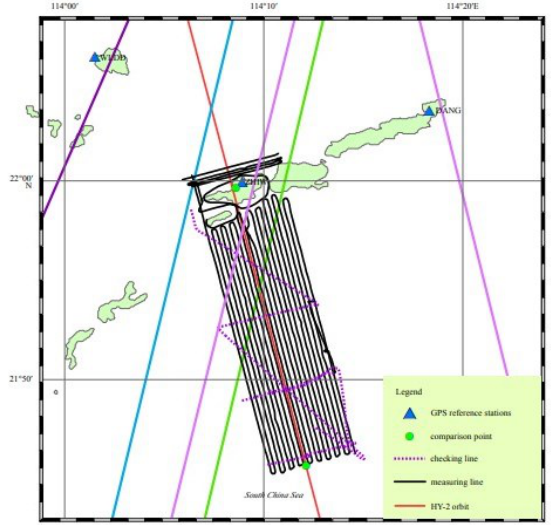
Figure 17. The research area, the three GPS reference stations and the HY-2 track (red line) are illustrated. The purple, blue, green, lilac and dark amethyst lines represent the altimeter footprint of ERS, ENVISAT, Sentinel-3A, T/P and Jason-1/2/3, respectively [20].